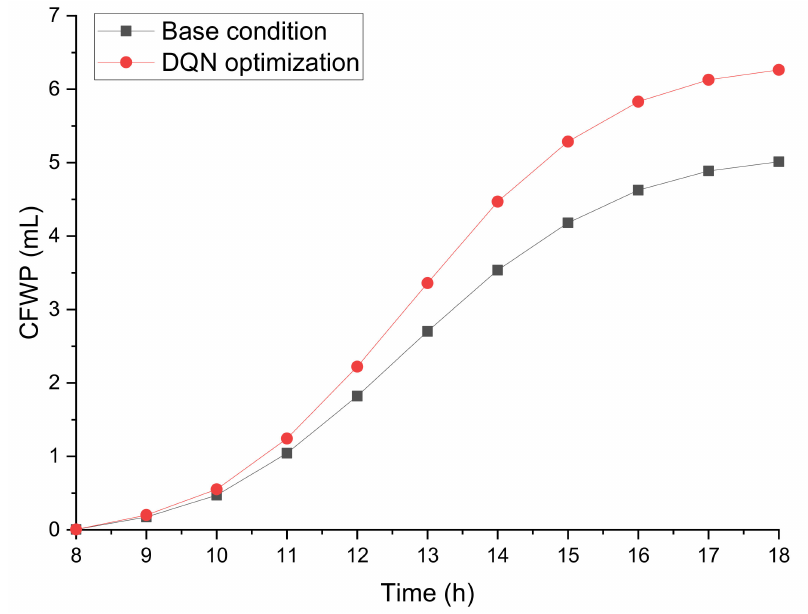
Figure 8. The cumulative freshwater production (CFWP)